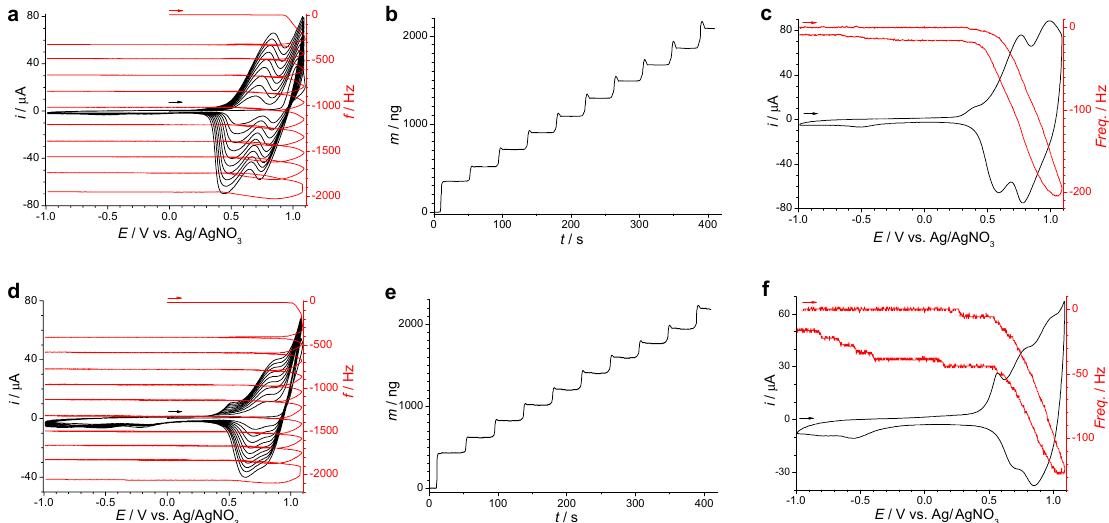
Figure 5. Ten successive CVs (black lines) and corresponding quartz microbalance frequency response (red lines) in the electropolymerization at platinum / quartz working electrodes of 0.1 mM solutions of ( a ) TPTCzSiOH and ( d ) TPHxCzSiOH and 0.1 M tetrabutylammonium perchlorate in MeCN / methylene chloride (1:4). Mass accumulation during electropolymerization of ( b ) TPTCzSiOH and ( e ) TPHxCzSiOH, calculated by applying the Sauerbrey equation. CVs (black lines) and corresponding quartz microbalance frequency response (red lines) for thin films of ( c ) PTPTCzSiOH and ( f ) PTPHxCzSiOH on platinum / quartz electrodes in 0.1 M tetrabutylammonium perchlorate in MeCN solutions. All CVs were registered from − 1.0 to 1.1 V with a sweep rate of 0.10 V s − 1 .